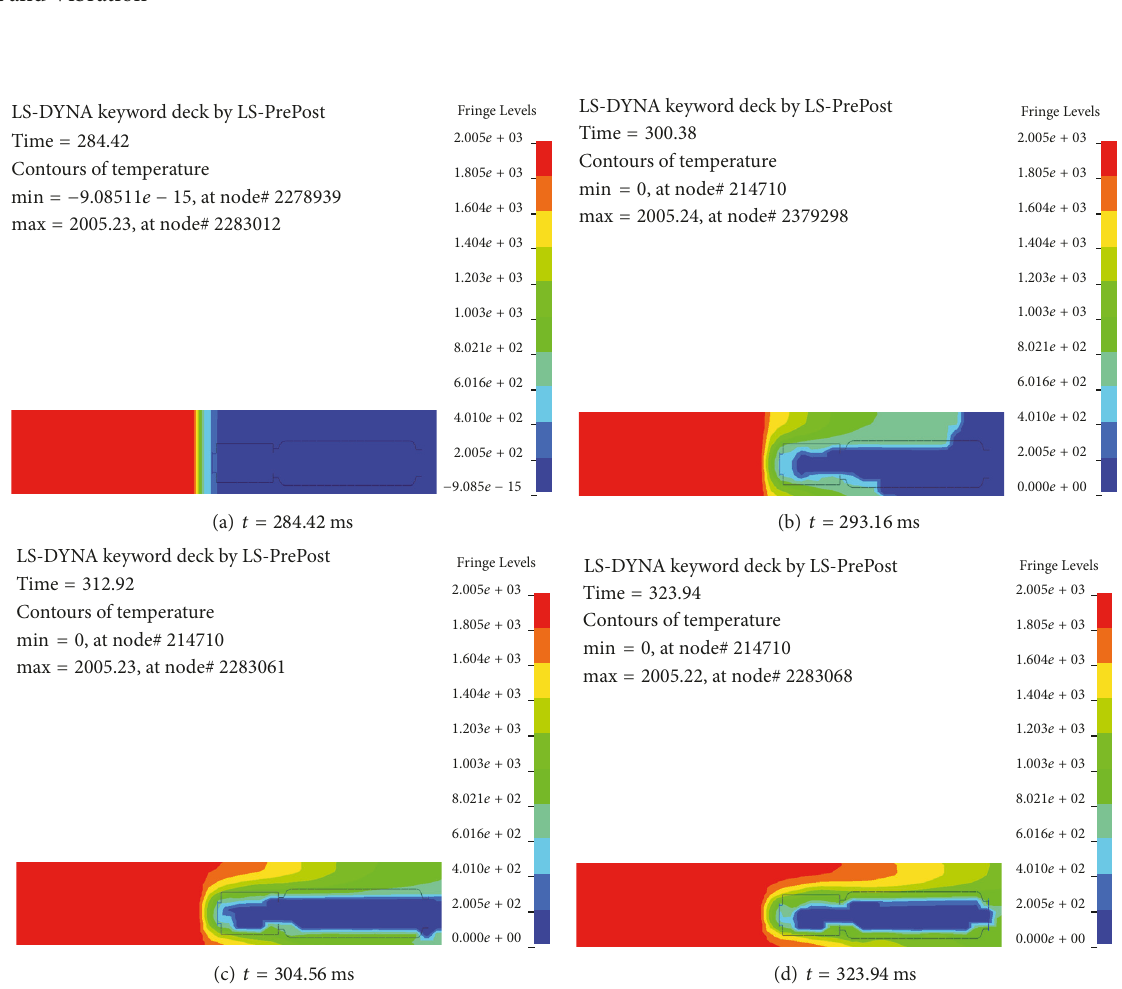
Figure 5: Temperature contour of the blast wave interaction with the rescue capsule in the tunnel.